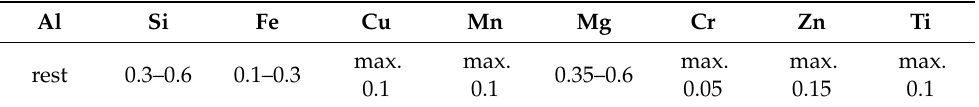
Table 1. Chemical composition of AA 6060 T4.